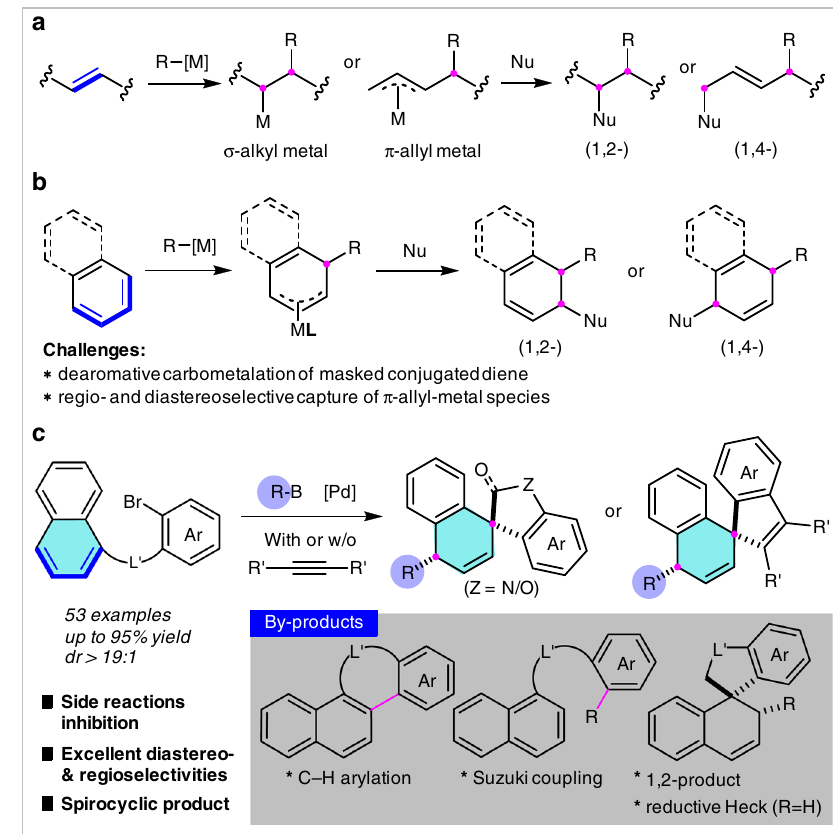
Fig. 1 Transition-metal-catalyzed difunctionalization of ole fi n and arene. a TM-catalyzed difunctionalization of alkene (well-developed) 2,9 – 16 . b Dearomative difunctionalization of naphthalene or benzene (unknown). c Dearomative 1,4-diarylation/vinylarylation of naphthalenes via Heck/Suzuki coupling (This work). [M] metal catalyst, Nu nucleophile, L ligand, L ′ linker, Ar